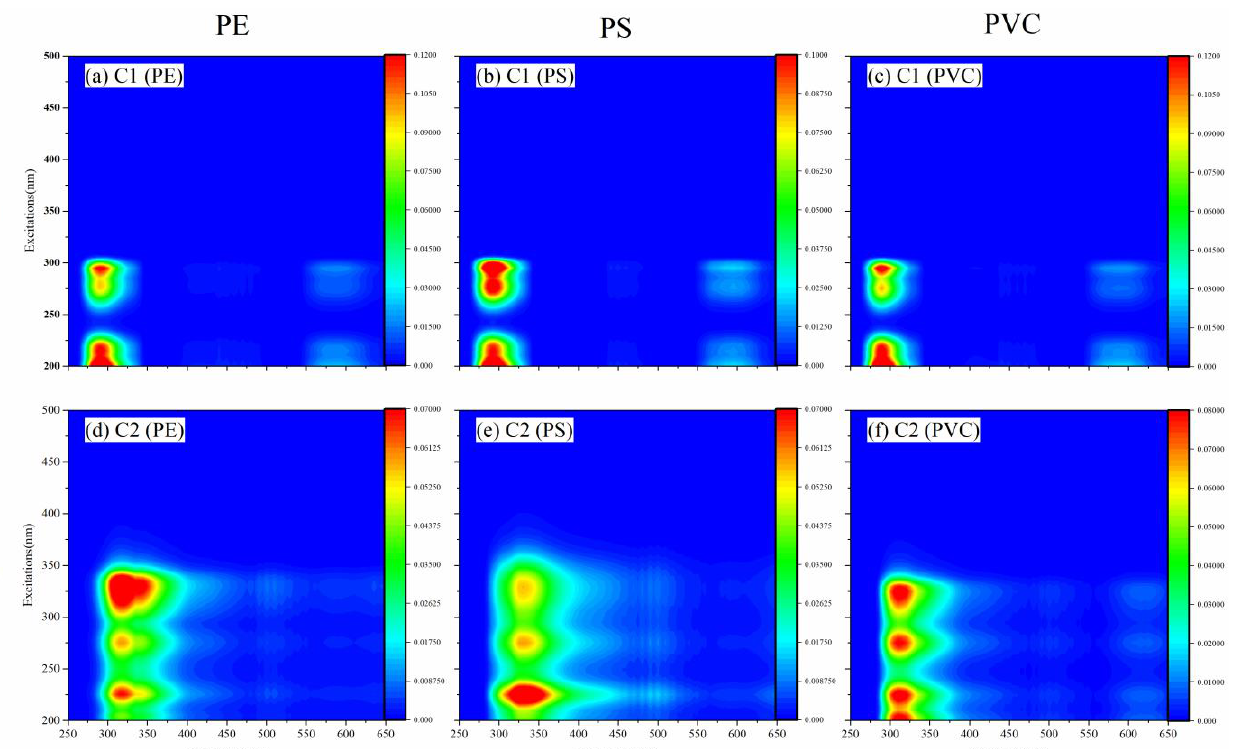
Figure 4. For each plastic type, component 1(C1) fell in the same region, peaking at 205(295, 275, 215)/290(Ex/Em) (Figure 4a–c). Component 2(C2) differed according to the specific